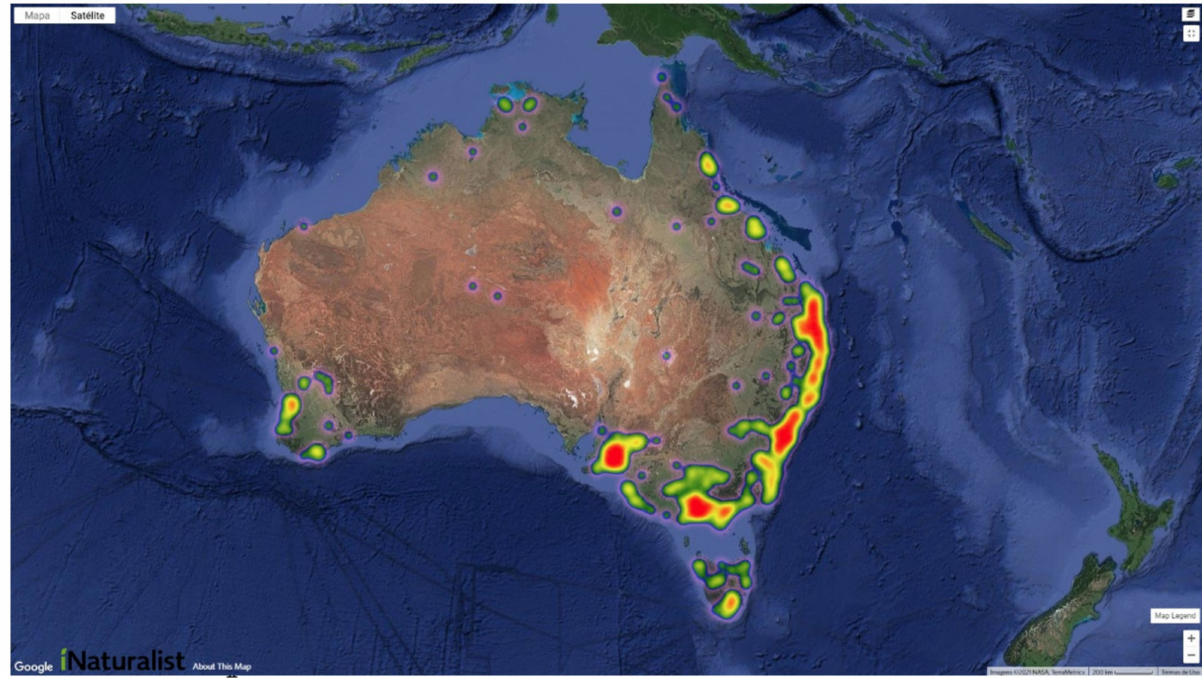
Figure 1. Heatmap showing the distribution of observations on Mozzie Monitors project on iNaturalist, in Australia. The warmer the colour, the more observations submitted in the